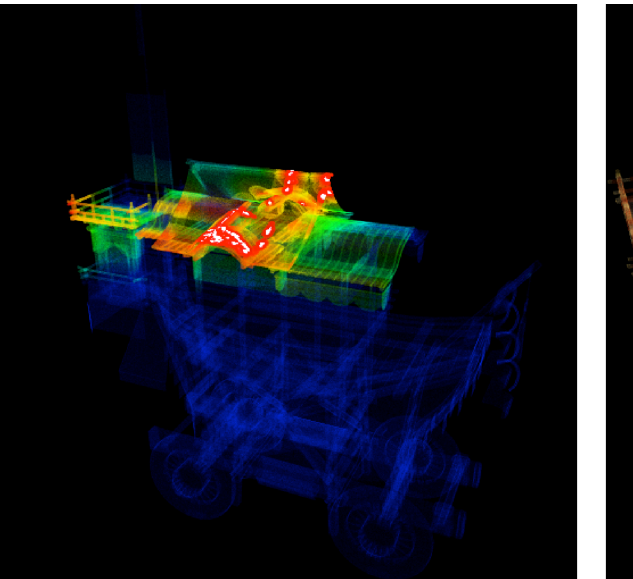
Figure 12. See-through collision visualization of the Ofune- hoko float without the street. Only the collision areas of the float are highlighted with the white